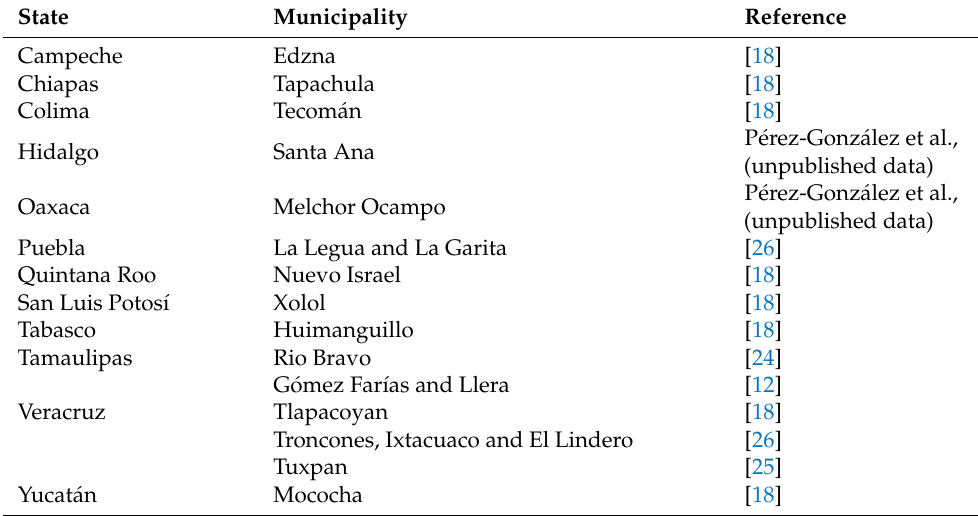
Table 4. States and municipalities of Mexico reporting Hirsutella citriformis .